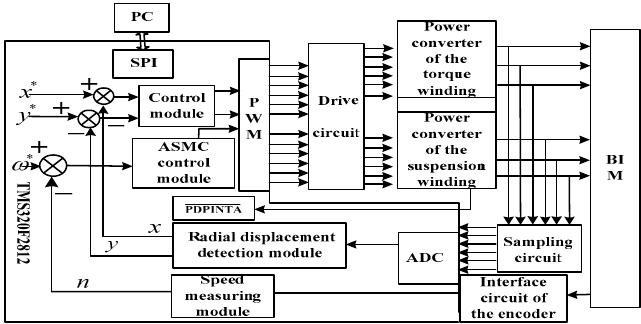
Figure 8. The experiment block diagram of the control system.